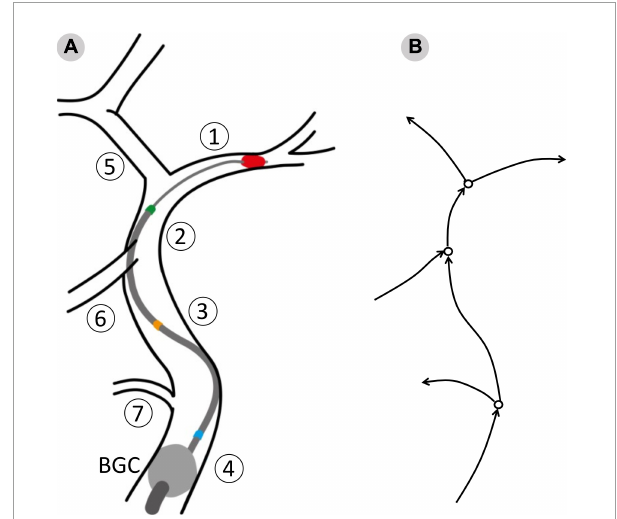
FIGURE3 The surgical procedure as modeled in openBF. Vessel numbering is the same as in Figure 1 . (A) The balloon guided catheter (BGC, gray circle) is located at the junction between Internal, External and Common Carotid. Three positions of the aspiration catheter are shown: Blue, aspiration in ICApp; Orange, aspiration in ICApd; GREEN, aspiration in ICAd. (B) 1D representation of the retrieval path and neighboring vessels. Arrows indicate the positive direction of flow.